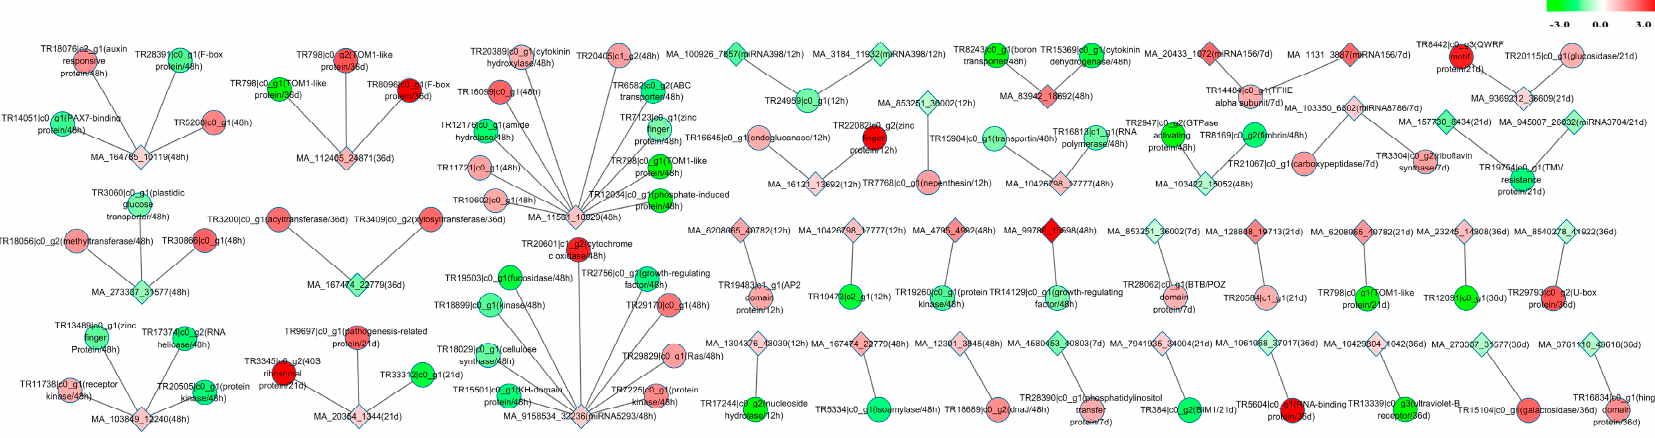
Figure 6. miRNA-mRNA interaction network. The network shows the predicted interactions between differently expressed miRNAs and their target DEGs in PEMs at five time points. Red indicates up-regulated mRNAs or miRNAs; green indicates down-regulated mRNAs or miRNAs. The color depth is based on the log 2 FC (Fold change H 2 -treatment/control). Circles indicate mRNAs; squares indicate miRNAs. An interaction is represented by one edge.